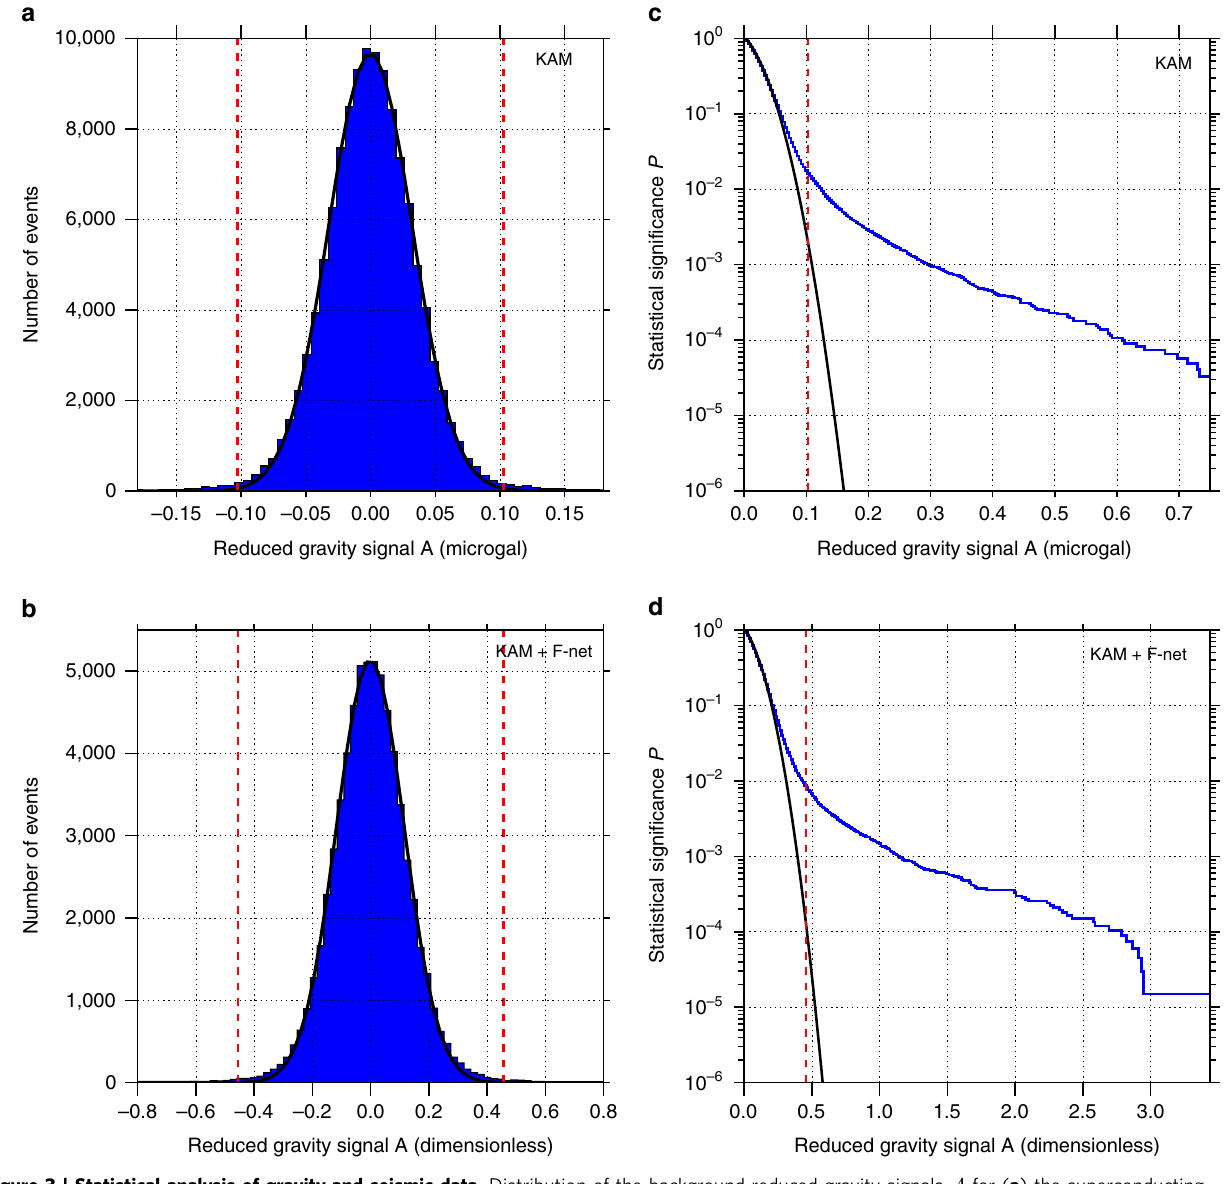
Figure 3 | Statistical analysis of gravity and seismic data. Distribution of the background reduced gravity signals A for ( a ) the superconducting gravimeter record only ( d ¼ 2, T ¼ 690s) and ( b ) the weighted stack of gravimeter and broadband seismometers records ( d ¼ 1, T ¼ 1,900s). The dashed red vertical lines represent the reduced gravity signal for the event (cid:4) A Tohoku j j . Note that the weighted stack is dimensionless. Empirical cumulative probability function (probability for a signal to exceed A ) (blue curve) for ( c ) the gravimeter record only and for ( d ) the weighted stack record. The probability to obtain a signal larger than A Tohoku (dashed vertical line) is 1.6% for ( c ) and 0.8% for ( d ). In all plots, the black curve corresponds to the best fitting Gaussian